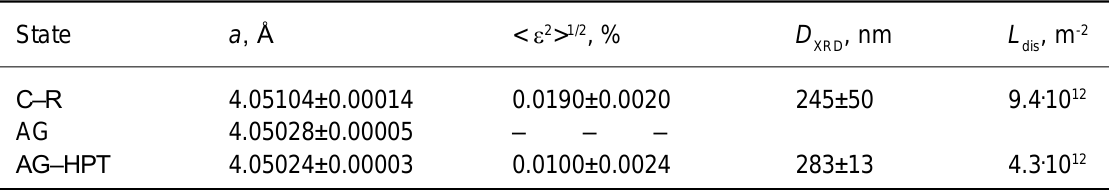
– dislocation dis